Question: Give a one-sentence summary of this figure.
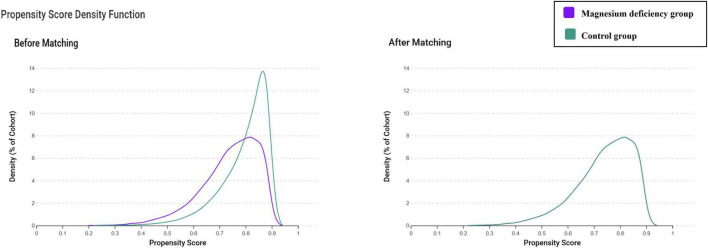
Answer: Baseline characteristics of hospitalized COVID-19 survivors with low magnesium status and matched controls before and after propensity score matching.